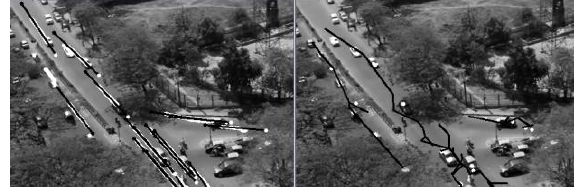
Figure ５ : Trajectories of Moving Objects & MST Clustering Clustering could result in grouping of trajectories belonging to different roads even if the roads are at right angle to each other. Trajectories of two roads tend to form a single cluster if there is only a gradual change in the slope of the trajectories (Figure ６ ).